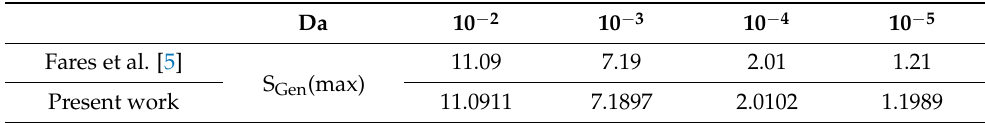
Table 4. Validation of the present code, for the entropy generation with Darcy number (Da), with a cavity by